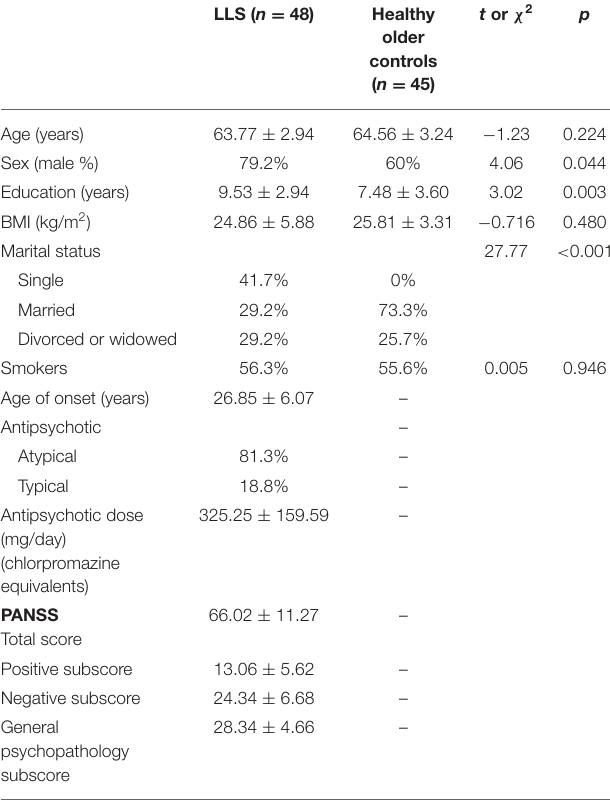
TABLE 1 | Characteristics of late-life schizophrenia (LLS) and healthy older